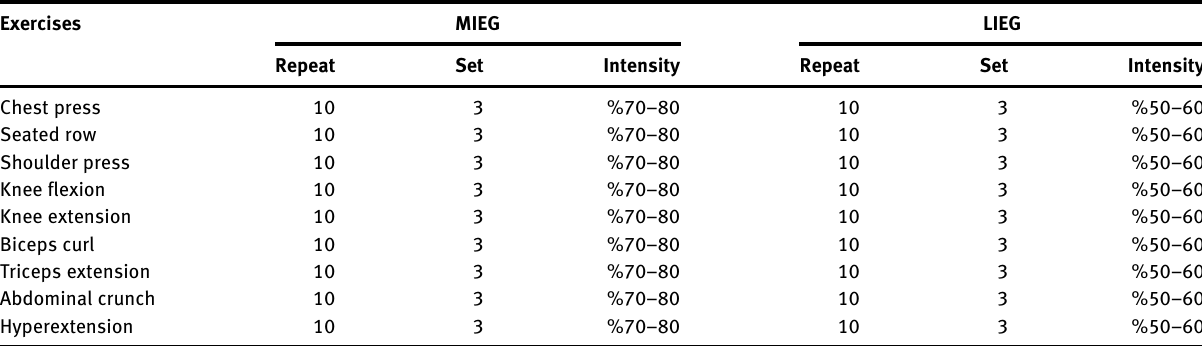
Table  : Eight-week resistance exercise